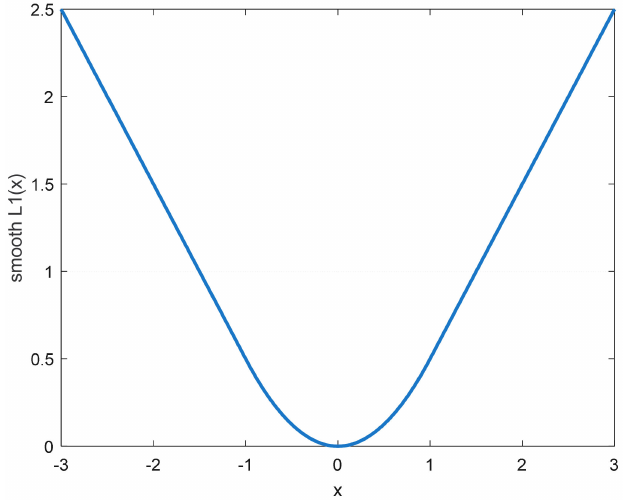
Figure 5. The curve of the Smooth L1